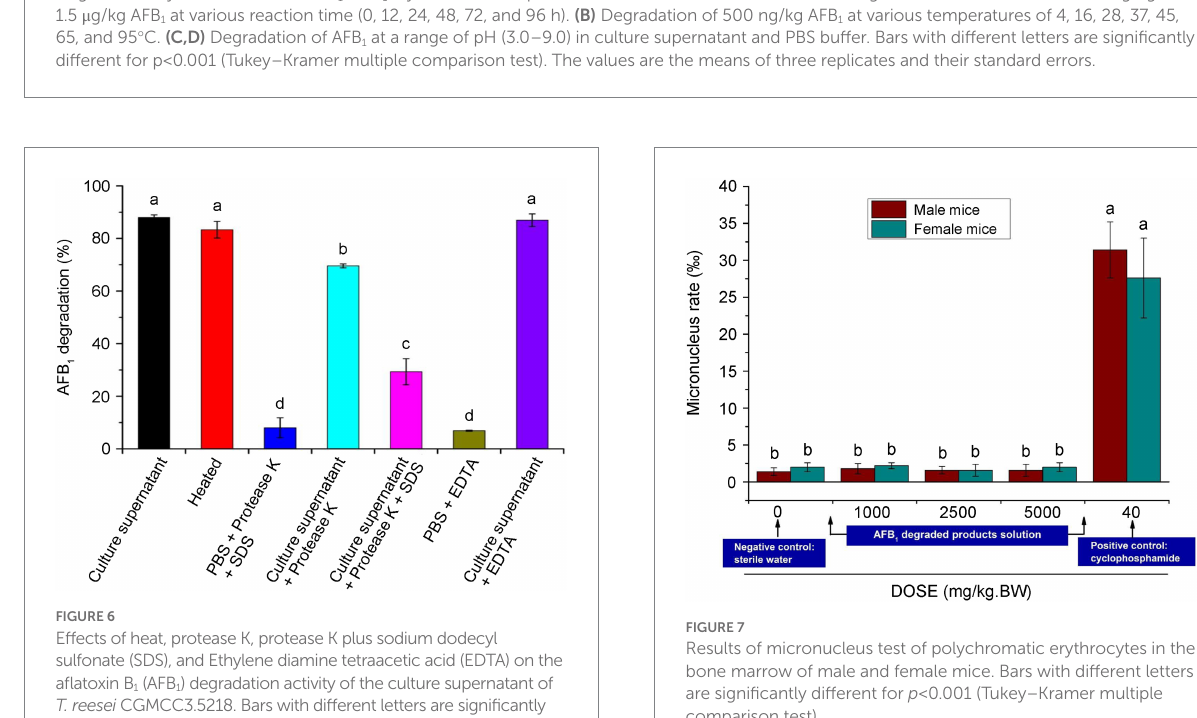
FIGURE 7 Results of micronucleus test of polychromatic erythrocytes in the bone marrow of male and female mice. Bars with different letters are significantly different for p < 0.001 (Tukey–Kramer multiple comparison test).